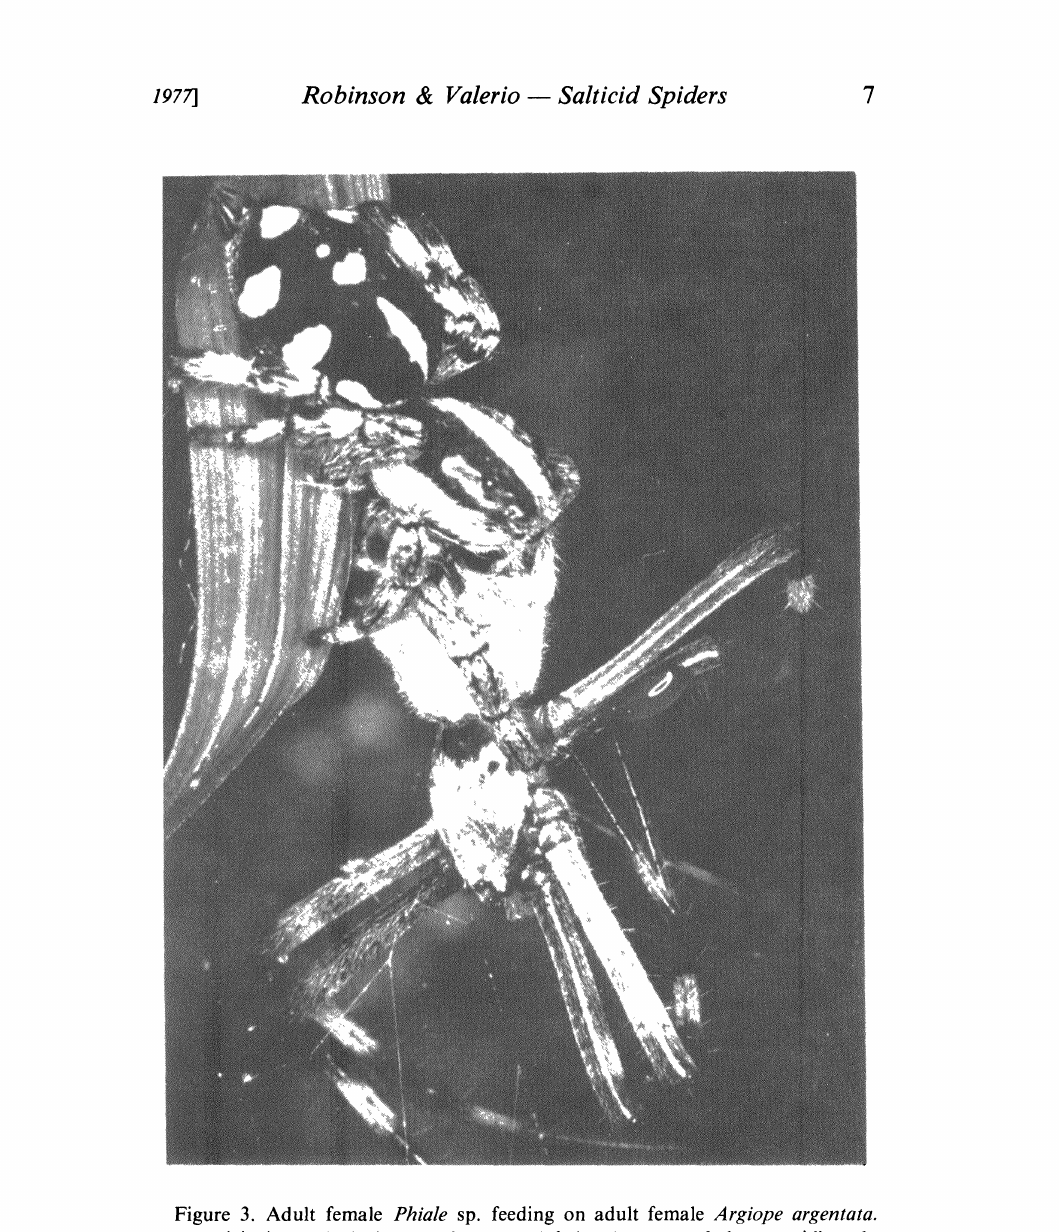
Figure 3. Adult female Phiale sp. feeding on adult female Argiope argentata. The salticid is perched close to the upper left hand corner of the araneid’s web. Old Gamboa Road, Canal Zone, Panama. May 19th